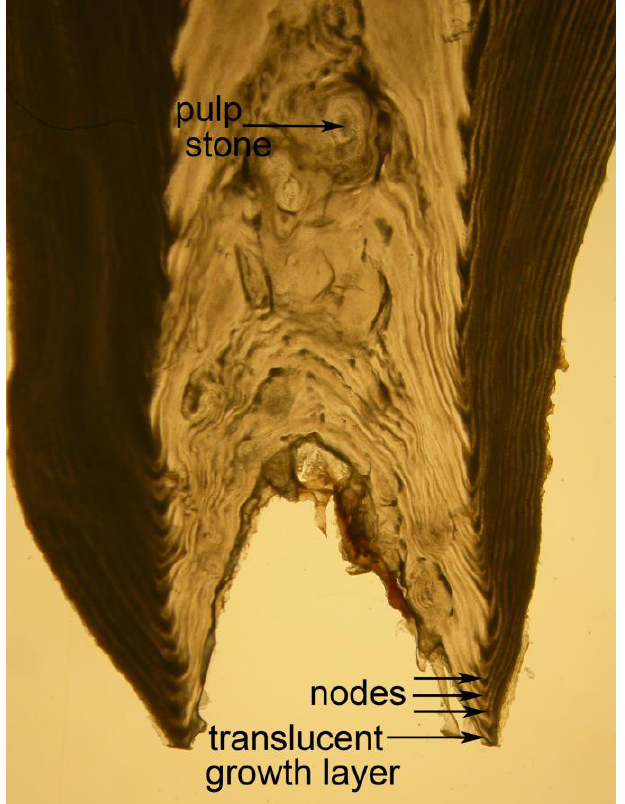
Fig. 5. Nodes and pulp stones in the root tip area. ARRB01-1116, MNR-5. Nodes are present at the dentine-cementum interface on both sides of the section. Pulp stones obscure the GLG sequence in the center portion of the dentine but a count can still be obtained using the